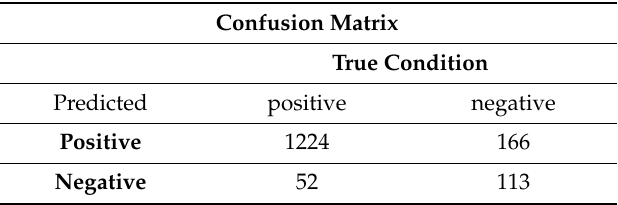
Table 1. Cell detecting